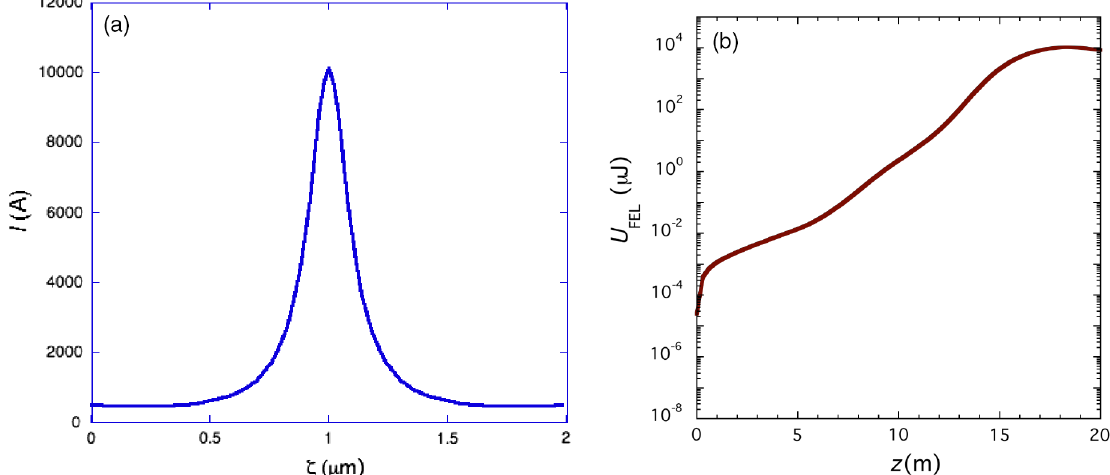
FIG. 9. (a) Current profile after microbunching section in ESASE scheme for LCLS parameters. (b) FEL energy for full beam having microbunch current as in (a), with central wavelength 1 . 41 Å (8.8 keV